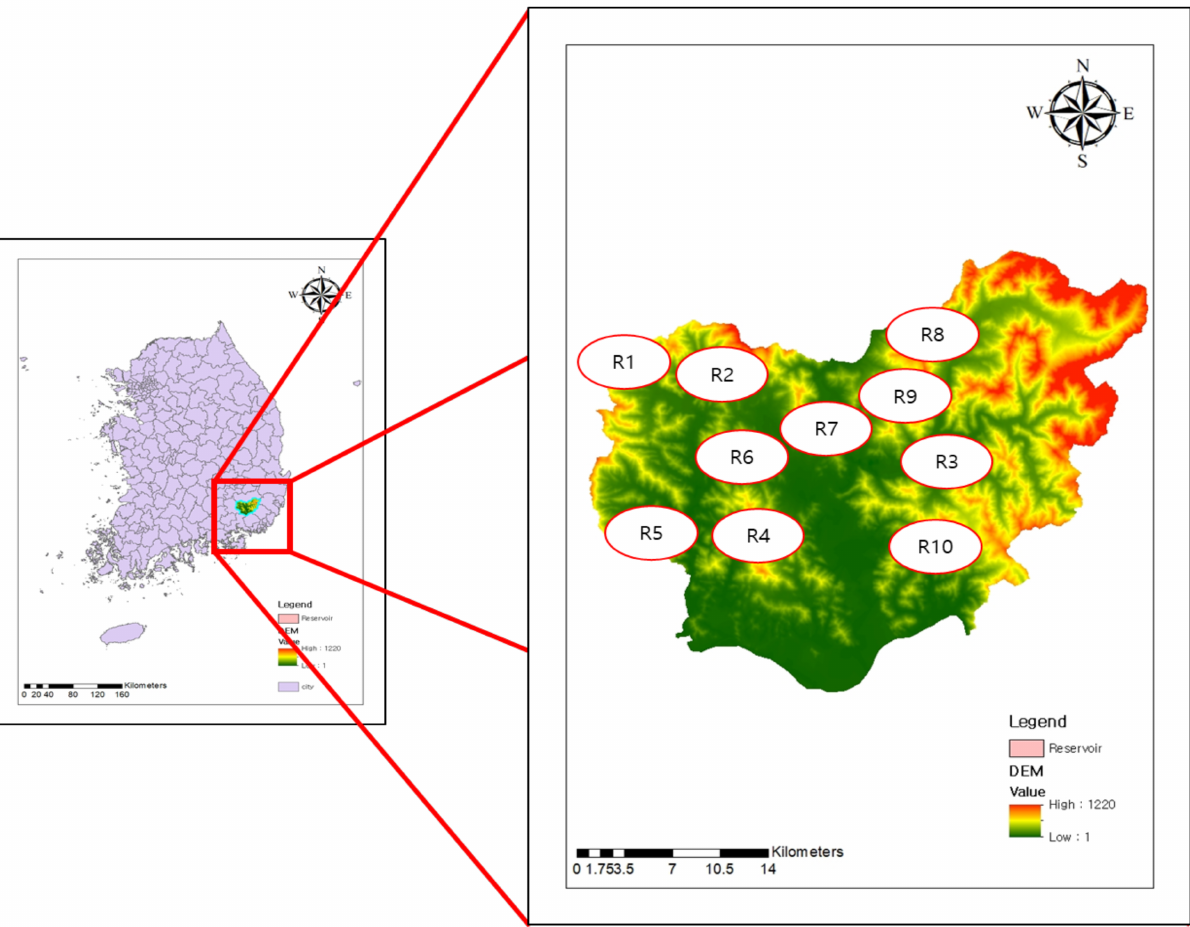
Figure 1. Study area and locations of 10 reservoirs including the Ga-Gog reservoir in Miryang city, Gyeongsangnam